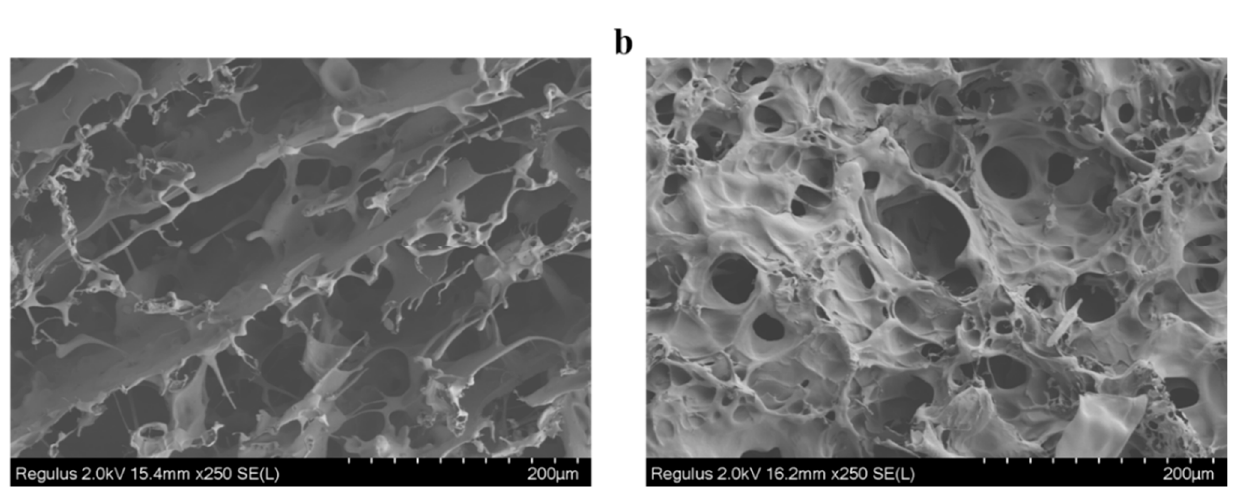
Figure 6. Microstructure of the SPI gel under the electron microscope. ( a ) Microstructure of the commercial MTGase-induced gel. ( b ) Microstructure of the BaMTGase-induced gel.